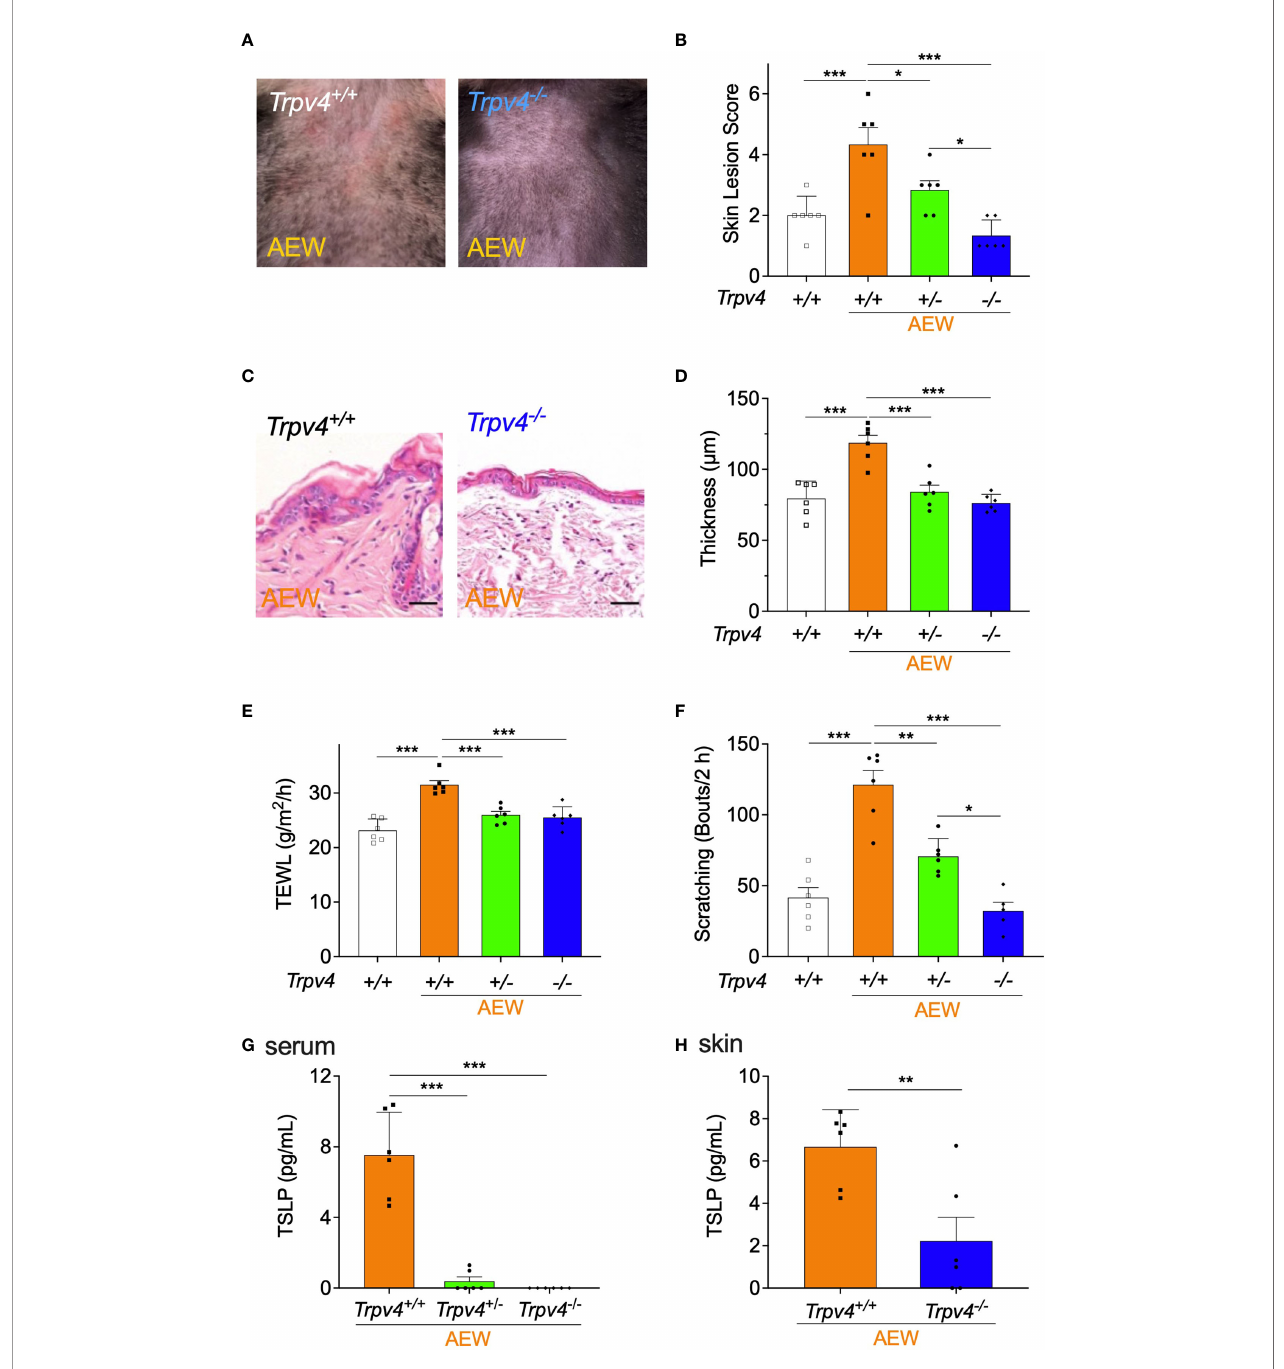
FIGURE 4 | The symptoms of dry skin and reduction in TSLP levels were less pronounced in TRPV4-de fi cient mice following AEW treatment. (A) The skin of Trpv4 -/- mice appeared less dry following AEW treatment. (B) On day 5 after treatment with AEW, the skin lesion scores gradually decreased in the following order: Trpv4 +/+ (n = 6) > Trpv4 +/- (n = 6) > Trpv4 -/- (n = 6). (C) Representative H&E-stained images of the skin tissues of Trpv4 +/+ and Trpv4 -/- mice following AEW treatment. (D) The epidermal thickness signi fi cantly decreased in both AEW-treated Trpv4 +/- mice (n = 6) and Trpv4 -/- mice (n = 6). (E) The values of TEWL signi fi cantly reduced in the AEW-treated Trpv4 +/- mice (n = 6) and Trpv4 -/- mice (n = 6). (F) The spontaneous scratching bouts were reduced in AEW-treated Trpv4 +/- mice (n = 6) and Trpv4 -/- mice (n = 6). (G) The serum levels of TSLP signi fi cantly decreased in the AEW-treated Trpv4 +/- mice (n = 6) and Trpv4 -/- mice (n = 6). (H) The levels of TSLP in the skin signi fi cantly reduced in the AEW-treated Trpv4 -/- mice (n = 6), compared to those of the control (n = 6). * p < 0.05, ** p < 0.01, *** p <